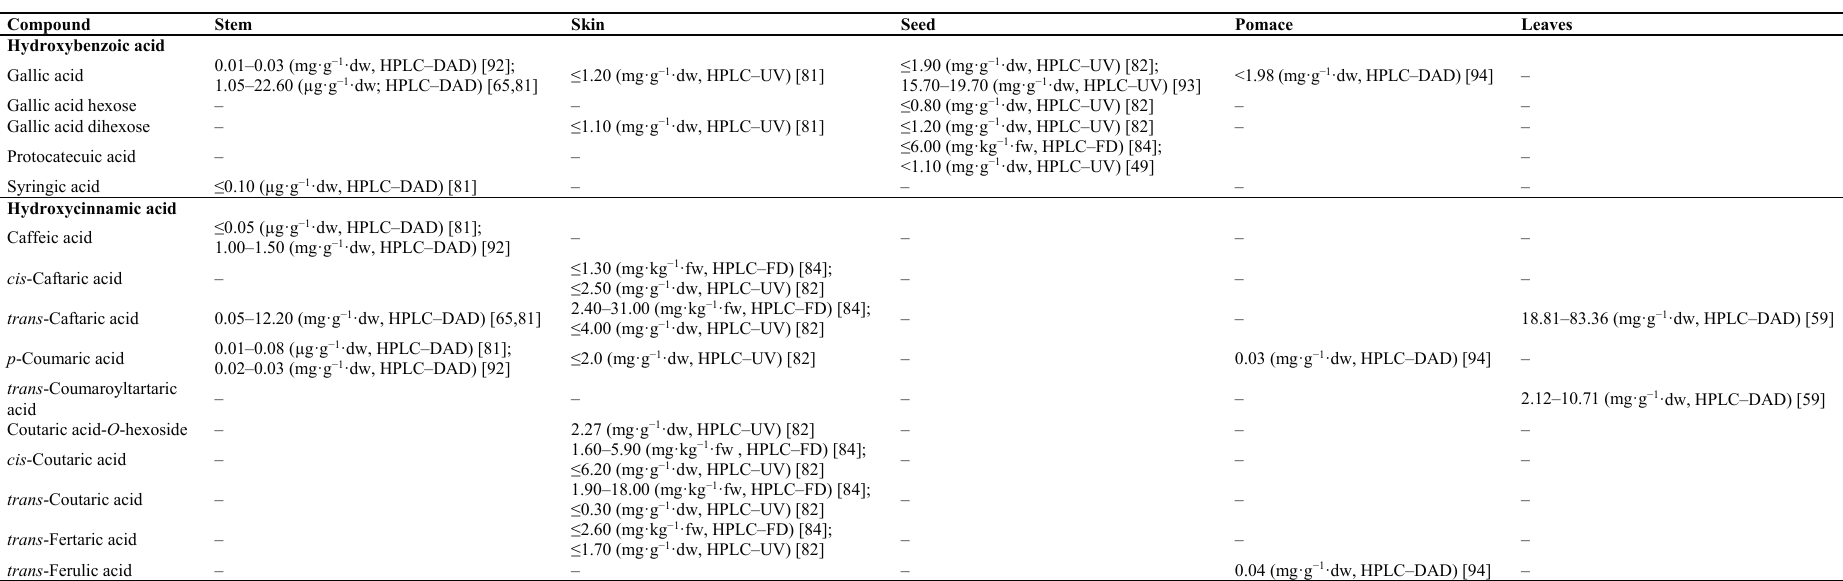
Table 2. Content in phenolic acids (analytical technique employed) in winery residues from different white varieties of Vitis vinifera L. Compound Stem Skin Seed Pomace Leaves Hydroxybenzoic acid Gallic